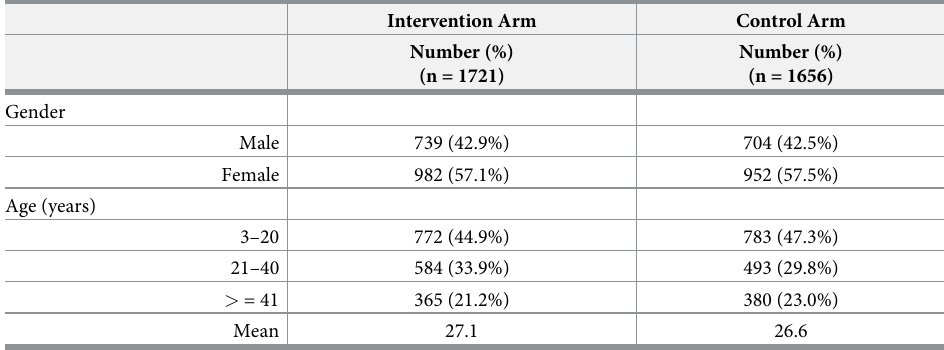
Table 1. Baseline participant